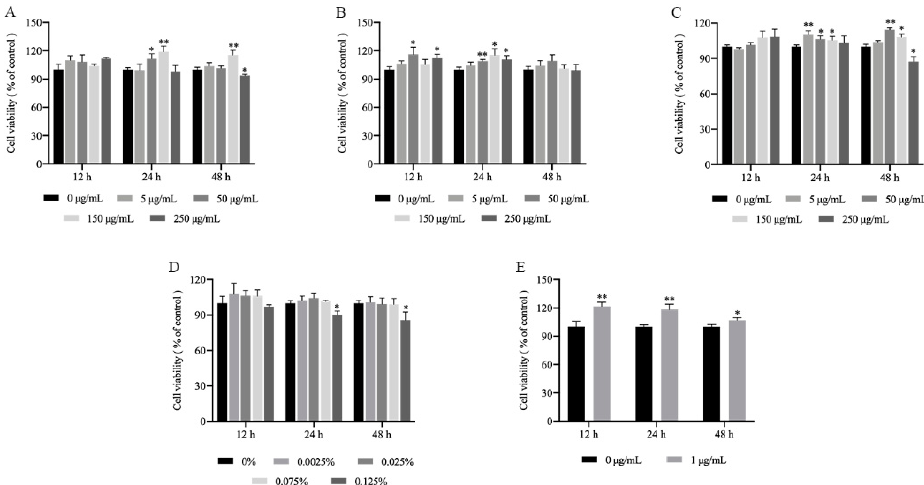
Figure 1. Cytotoxicity of ( A ) 30%MLF, ( B ) 50%MLF, ( C ) 75%MLF, ( D ) DMSO, and ( E ) LPS in RAW 264.7 cells for 12, 24, and 48 h. * p < 0.05 and ** p < 0.01 vs. 0 μ